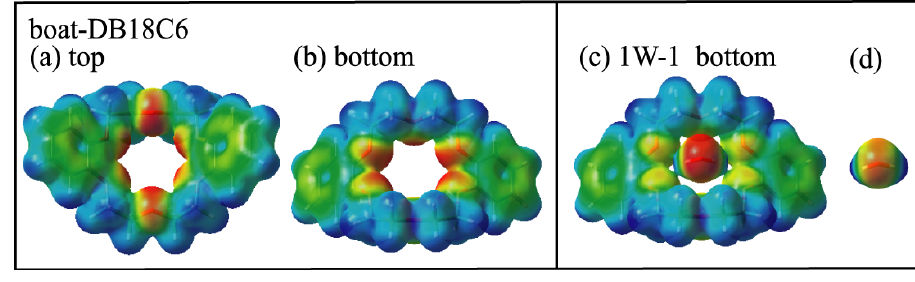
Figure 7. Electrostatic potential of DB18C6 from − 0.08 a.u. (red) to +0.08 a.u. (blue) on the surface of the same electron density